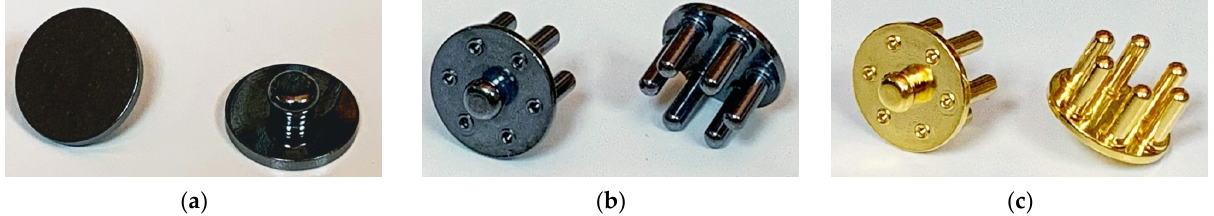
Figure 3. Reusable dry EEG electrodes: ( a ) flat dry Ag/AgCl electrode; ( b ) spike dry Ag/AgCl electrode; and ( c ) spike dry gold plated electrode.